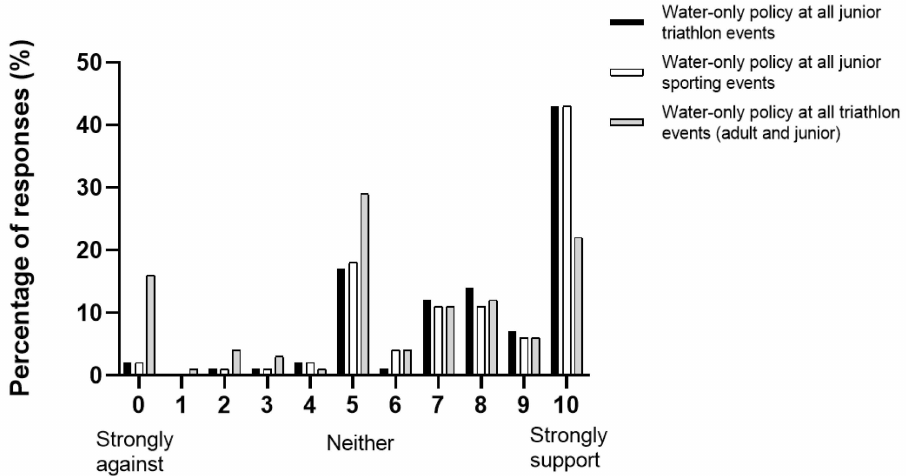
Figure 3. Opinion of parents with children participating in a triathlon event towards water-only policy for triathlon and junior sporting